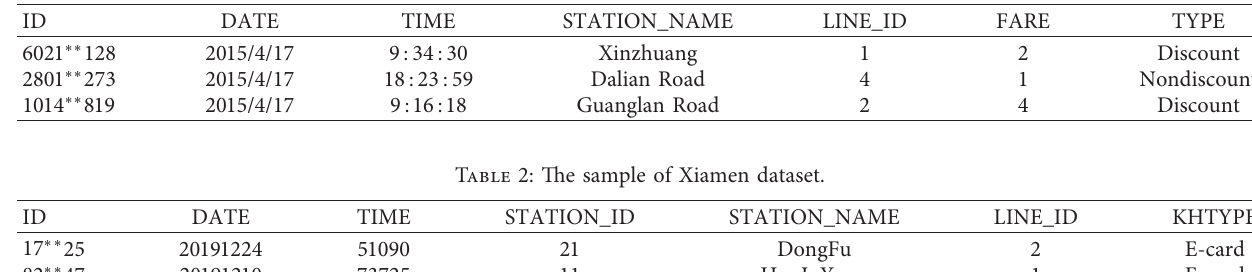
Table 1: The sample of Shanghai dataset.